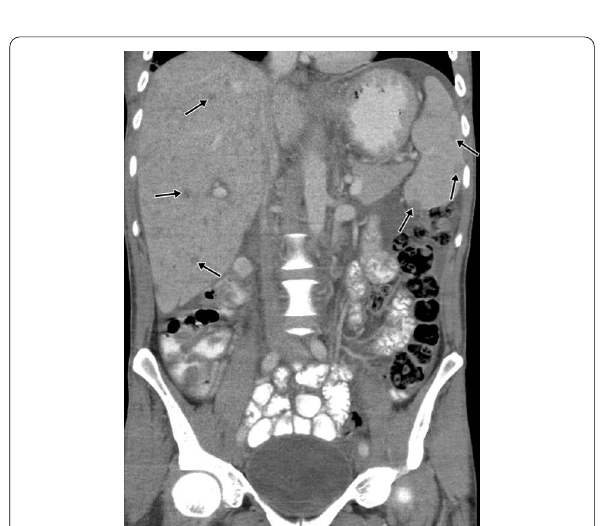
Fig. 29 A coronal contrast-enhanced CT image of a 43-year-old male shows multiple hypodense lesions (arrows) in the liver and